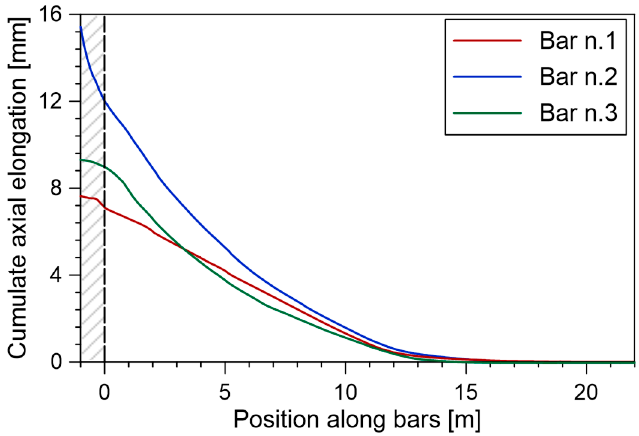
Figure 15. Cumulated axial elongation along anchors immediately after pre-tension.